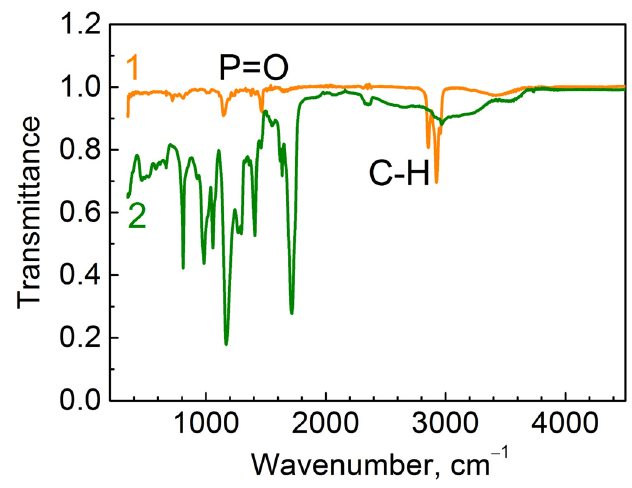
Figure 1. FTIR spectra of a layer of the synthesized quantum dots stabilized by trioctylphosphine oxide (TOPO) (1) molecules, and the quantum dots after replacement of the stabilizer with 2-carboxyethyl acrylate monomer molecules (2).